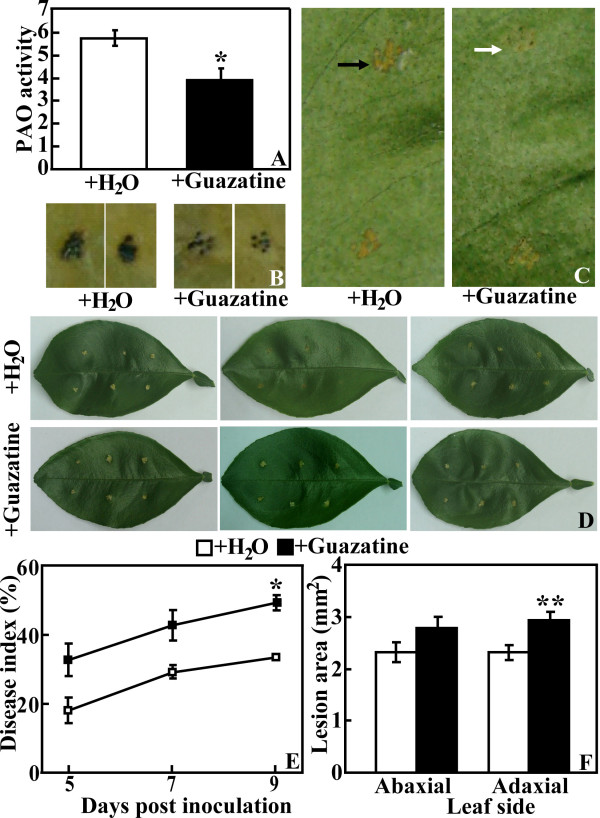
Effect of PAO inhibitor, guazatine acetate (Guazatine), on canker disease susceptibility of the transgenic line (TG9). (A-C) PAO enzyme activity (nmol acetylspermine/min/mg protein, A), DAB staining (B) and hypersensitive response (C, shown by arrows) of leaves treated with Guazatine or water (H2O), collected on 3 DPI. (D) Representative photographs showing symptoms of Guazatine or H2O-treated leaves after Xac inoculation for 9 d. (E-F) Disease index (E) and lesion size (data of 9 DPI, F) of the leaves treated with Guazatine or H2O after Xac infection. * and ** indicate the values are significantly different compared with WT at significance level of P < 0.05 and P < 0.01, respectively.